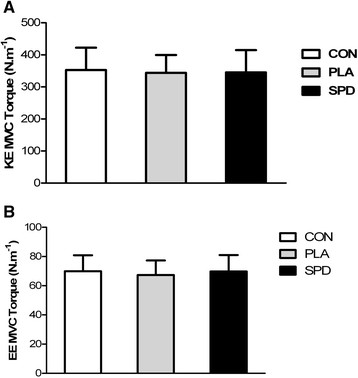
Mean (±SD) isometric maximal voluntary contraction torque of knee extensors (KE MVC Torque, Panel A) and of elbow extensors (EE MVC Torque, Panel B) in the 3 conditions (CON, PLA and SPD). For KE MVC Torque and EE MVC Torque, inter-group analysis was carried out using the Kruskal-Wallis one-way analysis; no statistical differences were found.